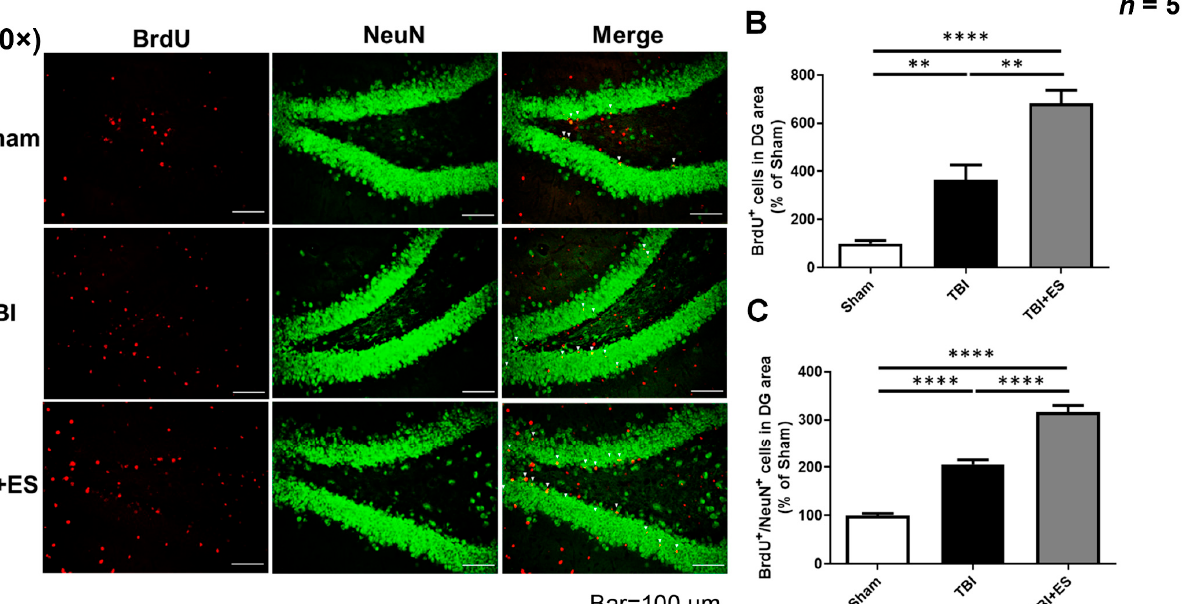
Figure 7. CES stimulates migration from the subgranular zone (SGZ) to the granular cell layer (GCL). ( A ) Representative pictures of the DCX immunofluorescence stain (green) of the dentate